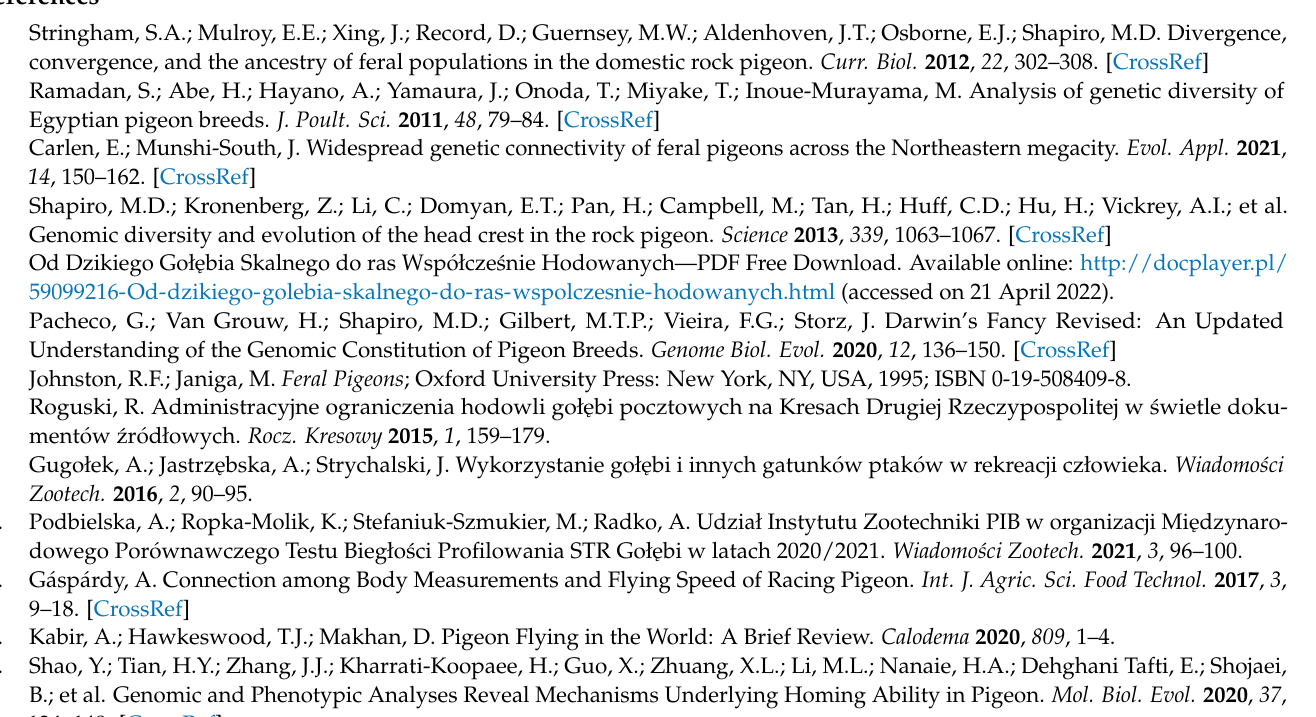
Table S4: Pairwise population Nm values based on F ST values, where: 1–PL; 2–BE; 3–DV; 4–SK; and 5–NL; Figure S1: Plot of mean likelihood L(K) and variance per K value from STRUCTURE HARVESTER on a dataset containing 519 individuals; Figure S2: Plot of mean likelihood L(K) and variance per K value from STRUCTURE HARVESTER on a dataset containing 519 individuals divided into five populations by country of origin; Figure S3: (A) Delta K values obtained with STRUCTURE HARVESTER. (B) Rate of change in the likelihood distribution (mean) obtained with STRUCTURE HARVESTER. (C) STRUCTURE software clustering at K = 4, where: 1–PL; 2–BE; 3–DV; 4–SK; and